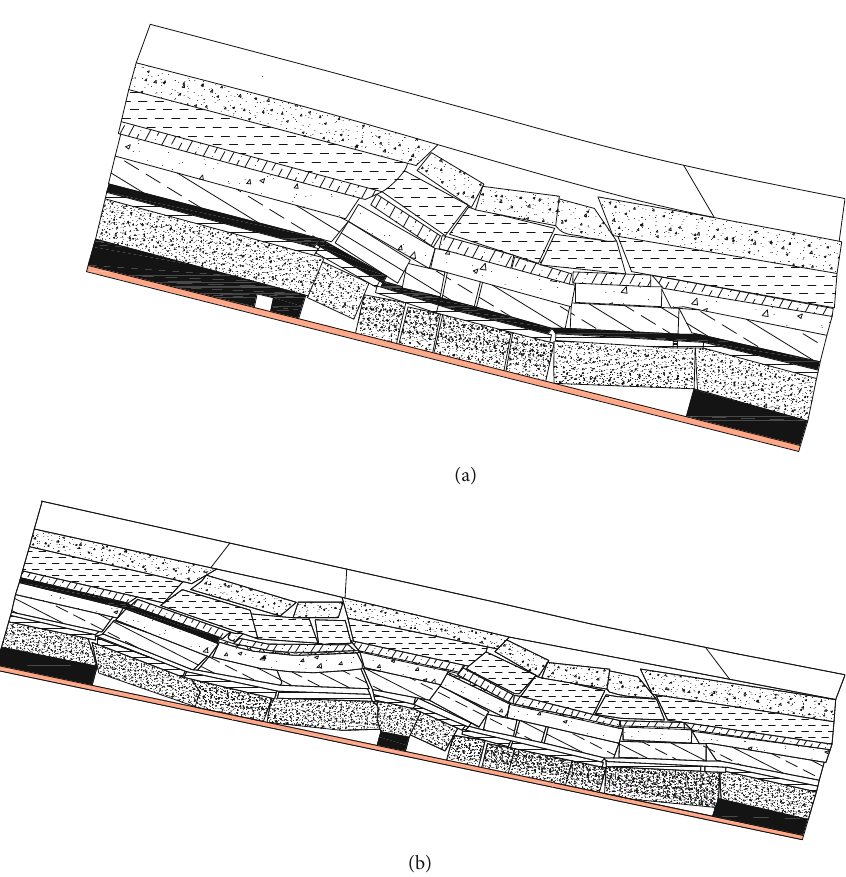
Figure 14: Roof hinged structure in di ff erent mining stages. (a) Structure in gob W1121. (b) Structure in gob